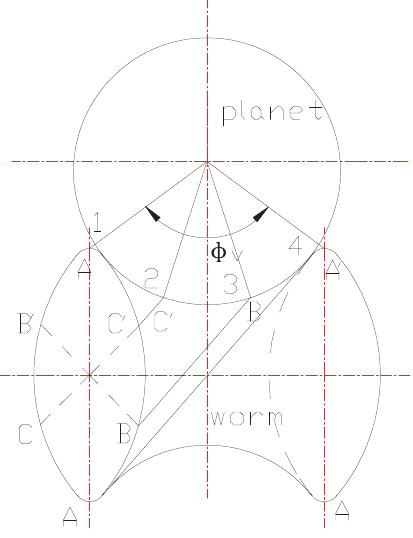
Fig. 2. Space phase relation of the worm